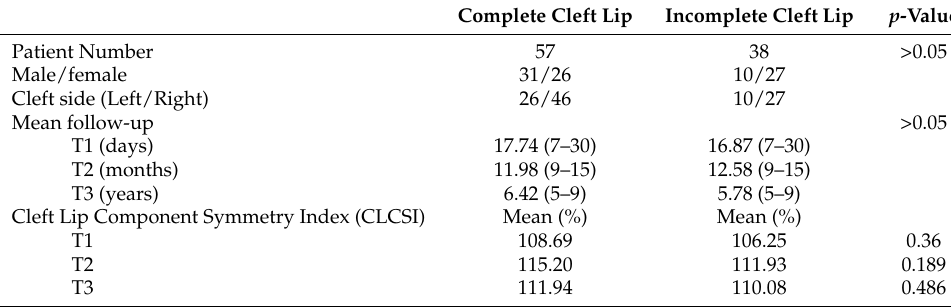
Table 1. Demographic data and follow-up.